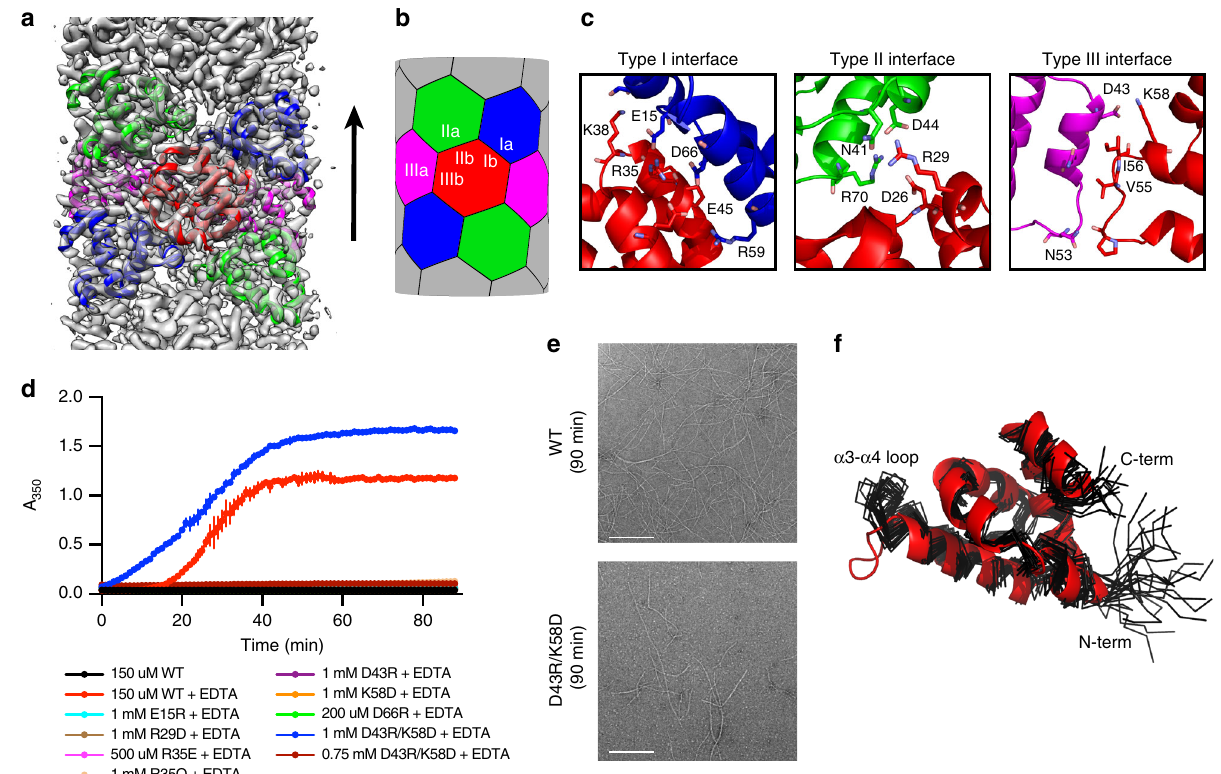
Fig. 6 The structural basis for unidirectional polymerization of CARD9. a Cryo-EM density for CARD9 2 − 152/I107E fi laments. Density is only present for the CARD core of the assembly. Seven CARDs of the modeled structure are shown, depicting the six CARDs contacted by any one CARD, colored as in b . Arrow indicates the direction of polymerization. b Schematic of the type I, II, and III interaction interfaces utilized by the CARD9 CARD. c Detail of the CARD interaction type I, II, and III interfaces, with residues involved in the interaction shown as sticks. CARDs are colored as in b . d CARD9 2 −− 97 polymerization assay. At time t = 0, a super-stoichiometric concentration of EDTA was added to each CARD, which were pre-saturated with 1:1 Zn 2 + . Polymerization was monitored by absorbance at 350 nm. Vertical bars represent the s.d. of three technical replicates. See NS-EM endpoint images in e and Supplementary Fig. 6A. For mutants D66R and R35E, Zn 2 + removal at higher concentrations does lead to increased A 350 , but without visible fi laments by NS-EM (Supplementary Fig. 6B), indicating that the mutations are destabilizing and lead to non-speci fi c aggregation upon Zn 2 + removal at the higher concentrations. Source data are provided in Source Data fi le. e NS-EM micrographs of CARD9 2 − 97/WT and CARD9 2 − 97/D43R/K58D generated at the endpoint of the assay in d . Scale bars are 500 nm. f Alignment of the apo CARD9 CARD NMR structure (black, PDBID 6E26 [http://dx.doi.org/10.2210/ pdb6E26/pdb]) and CARD Cryo-EM structure